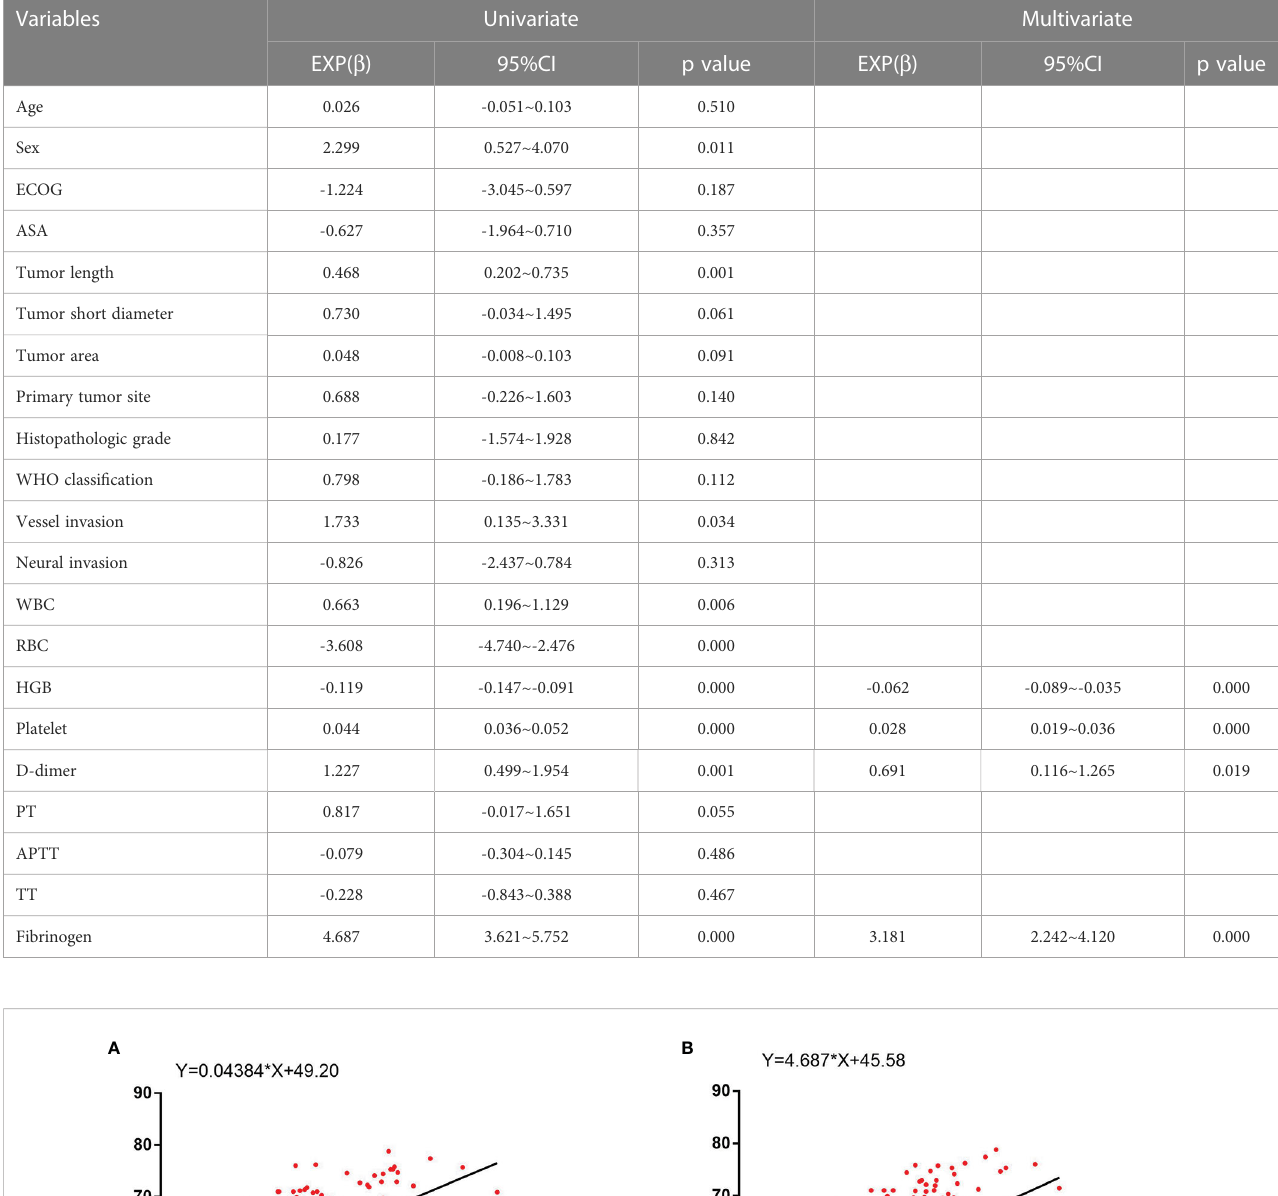
TABLE 7 In fl uencing factors of MA in patients with gastric cancer.